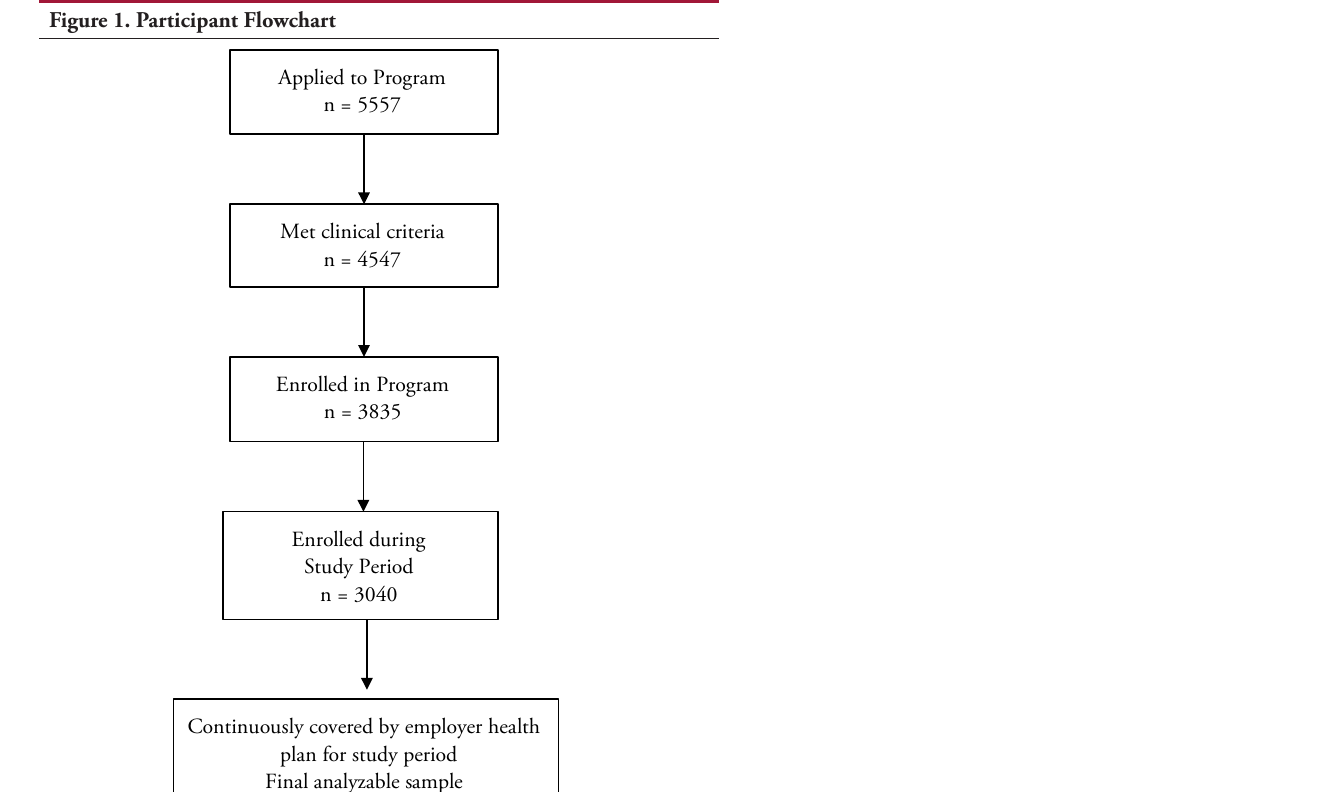
Figure 1. Participant